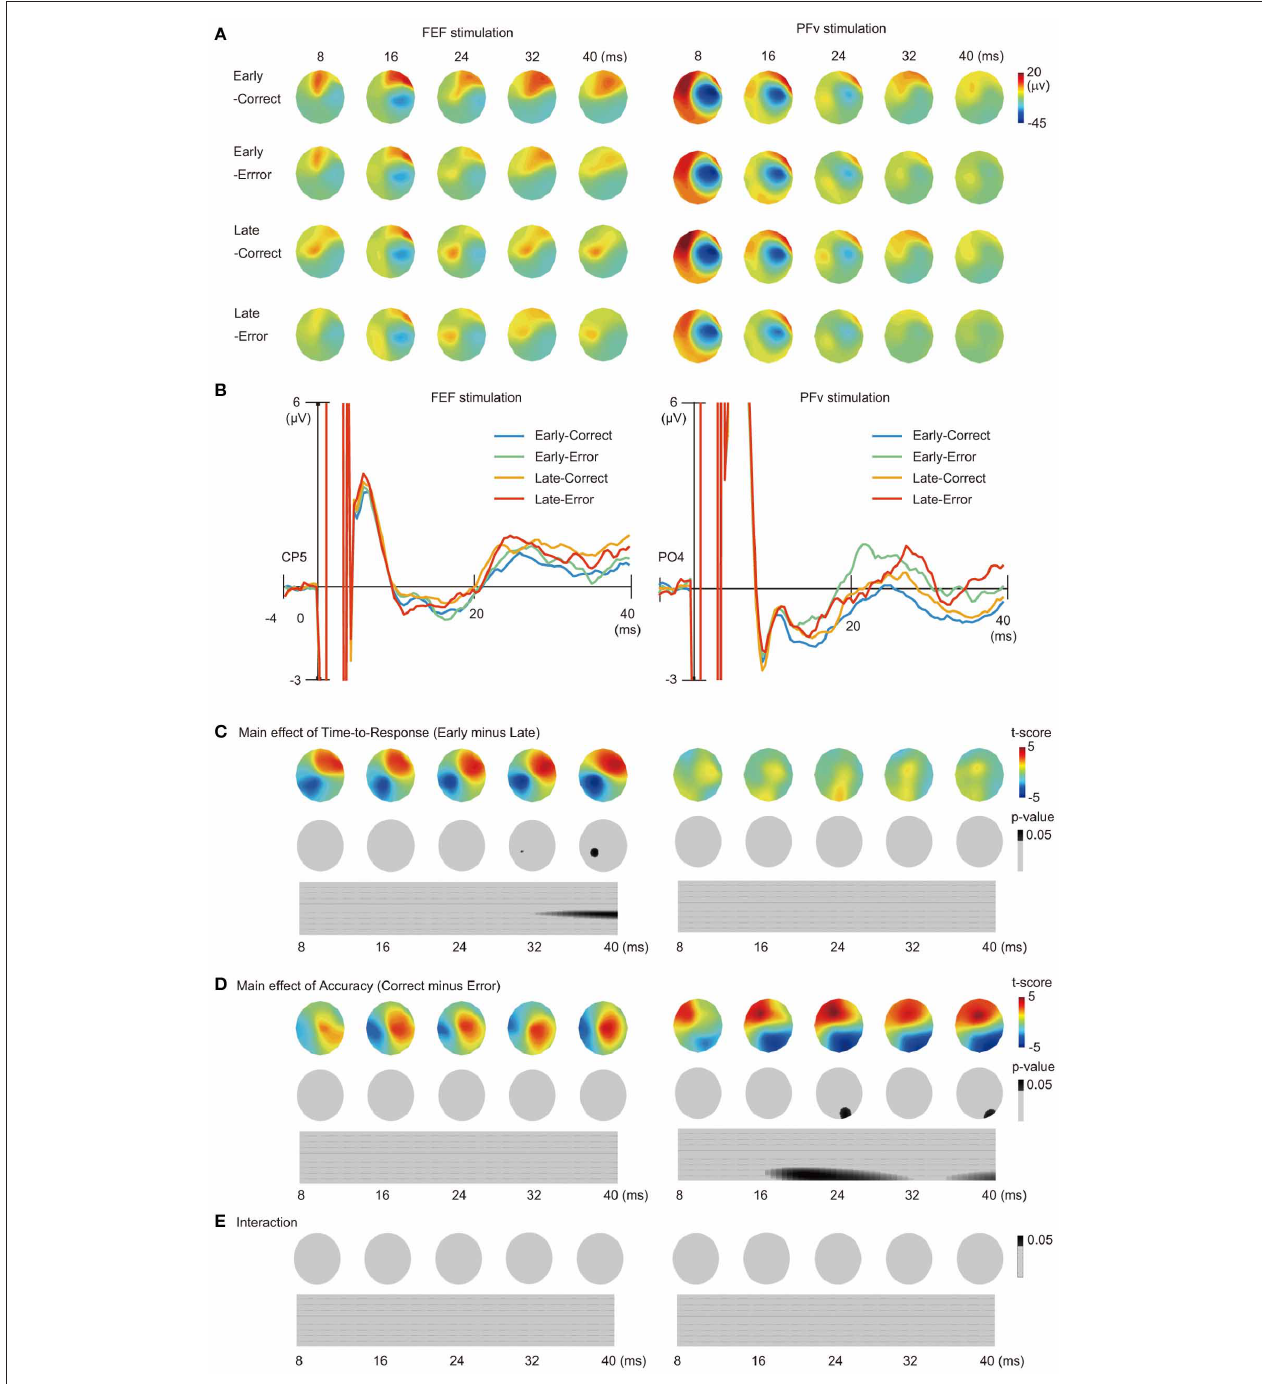
FIGURE 2 | TMS-EEG experiment. (A) Scalp patterns of TMS-EPs shown in time bins of 8ms after TMS. Data in which TMS was given early or late during the decision process and data in which subjects made correct or erroneous response are shown separately. FEF (left) and PFv stimulation (right). (B) Waveform of TMS-EPs from CP5 electrode in FEF stimulation (left) and that from PO4 electrode in PFv stimulation (right). Time bins in which there was a significant main effect of Time-to-Responsefactor (Early vs. Late) and those in which there was a significant main effect of Accuracy factor (Correct vs. Error) are indicated at the bottom of the trace by red tics.